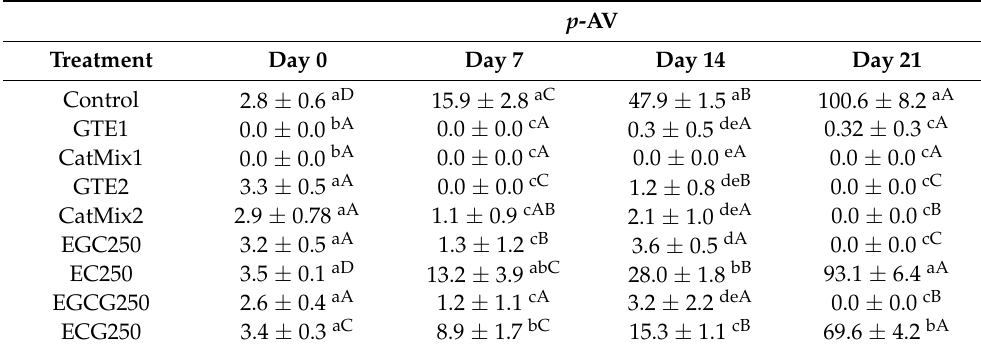
Table 2. Changes in the p -anisidine value ( p -AV) in DHA-rich oil supplemented or not with green tea extracts or catechins during storage at 30 ◦ C for 21